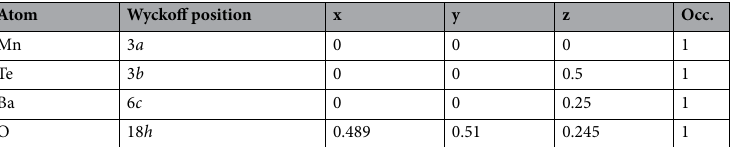
Table 1. Rietveld refinement results at room temperature for BMTO with space group R ¯ 3 m and unit cell parameters a = b = 5.814 Å, c = 14.243 Å and α = 90 ◦ , β = 90 ◦ , γ = 120 ◦ . The goodness of Rietveld